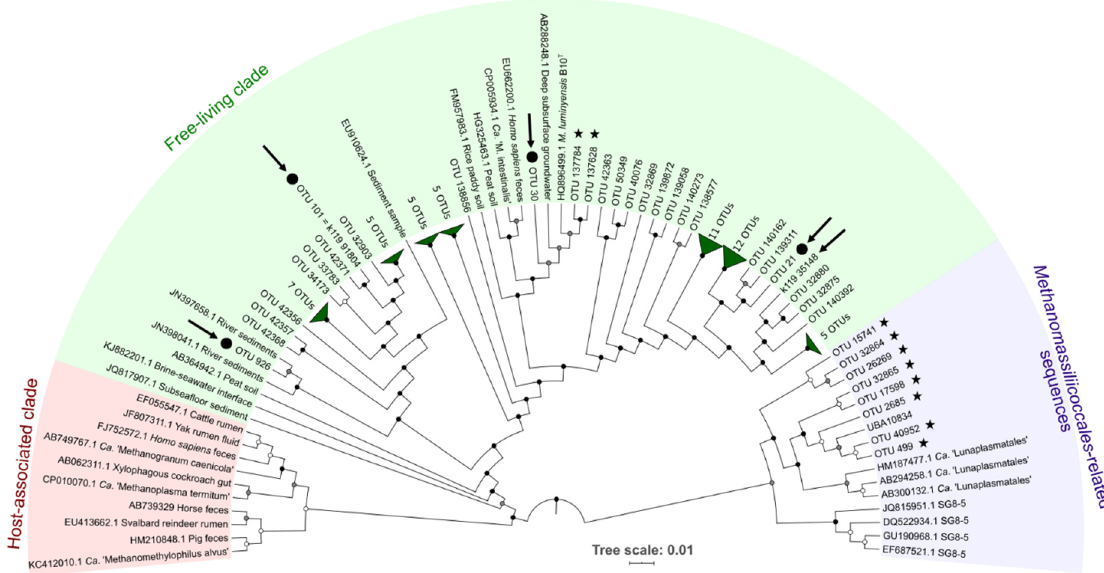
Figure 2. Dendrogram showing the relationships between 16S rRNA gene sequences (253 bp) detected in environmental samples, in substrate-amended slurry (PENF slurry) and inferred to metagenome-assembled genomes (MAGs), among Methanomassiliicoccales [22]. The 85 OTUs of Methanomassiliicoccales detected in this study are shown on this dendrogram. OTUs detected only in environmental samples are indicated by a black star. OTUs without a symbol were detected in the culture-based experiment performed with the sediment PENF. OTUs indicated by a circle were detected both in bulk samples and in the culture-based experiment. The 16S rRNA gene sequences k119_35148 and k119_91804 were extracted from the metagenome sequences of the culture-based experiment PENF, after 8 weeks of incubation. Sequences discussed in the text are indicated by black arrows. The Methanomassiliicoccales -related sequences encompassed representative 16S rRNA gene sequences of Ca. ‘Lunaplasmatales’, UBA10834 and SG8-5 [80]. This reconstruction was performed on partial 16S rRNA gene sequences (253 bp), using the BIONJ method [81], with the modifications of Jukes and Cantor and using 1000 bootstrap replicates. Black-filled dots indicate nodes with bootstrap supports <50%, grey-filled dots 50–75%, and white-filled dots show support values between 75 and 100%. The top-right insert indicates the relative abundance of the main Methanomassiliicoccales -affiliated OTUs in the substrate-amended slurry PENF, after 8 weeks of